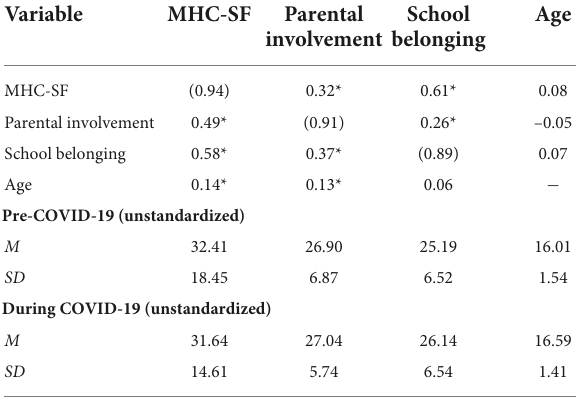
TABLE 2 Descriptive statistics and